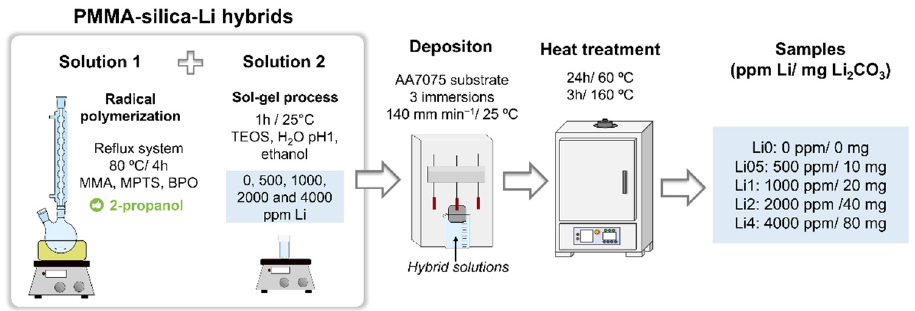
Figure 1. Experimental procedure used to prepare PMMA–silica–Li hybrids.